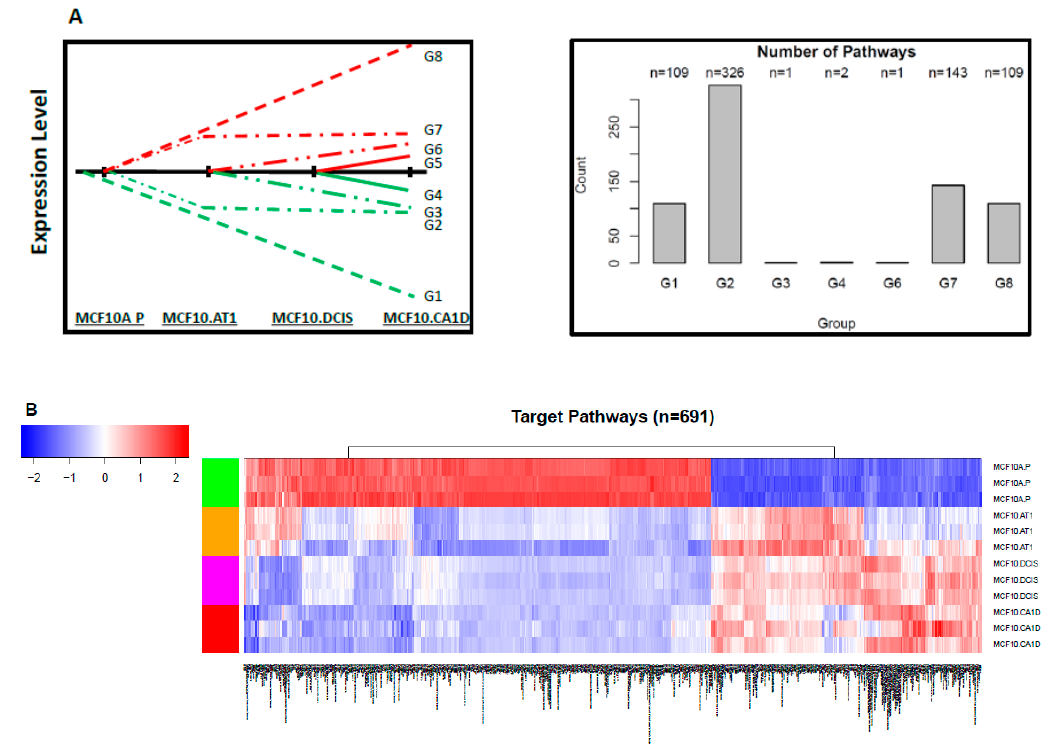
Figure 7. Target pathways that changed significantly during breast cancer progression. ( A ) Schematic showing the eight patterns of interest and the number of target pathways that mapped to each group. ( B ) Heat map showing the expression pattern of target pathways that significantly changed, thus depicting global target pathway changes across the spectrum of breast cancer progression. The color key shows blue as the lowest expression and red as the highest expression.